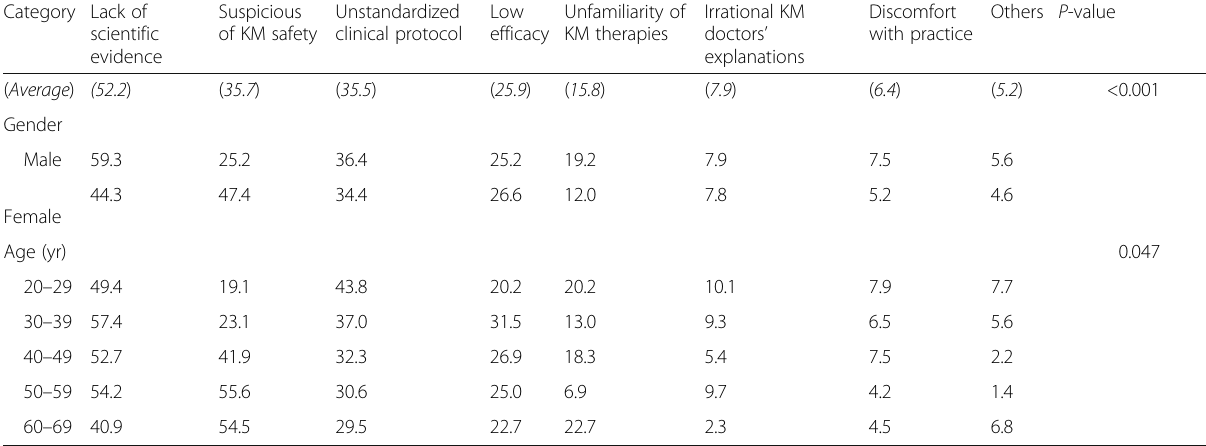
Table 4 Reasons for distrusting KM therapies in